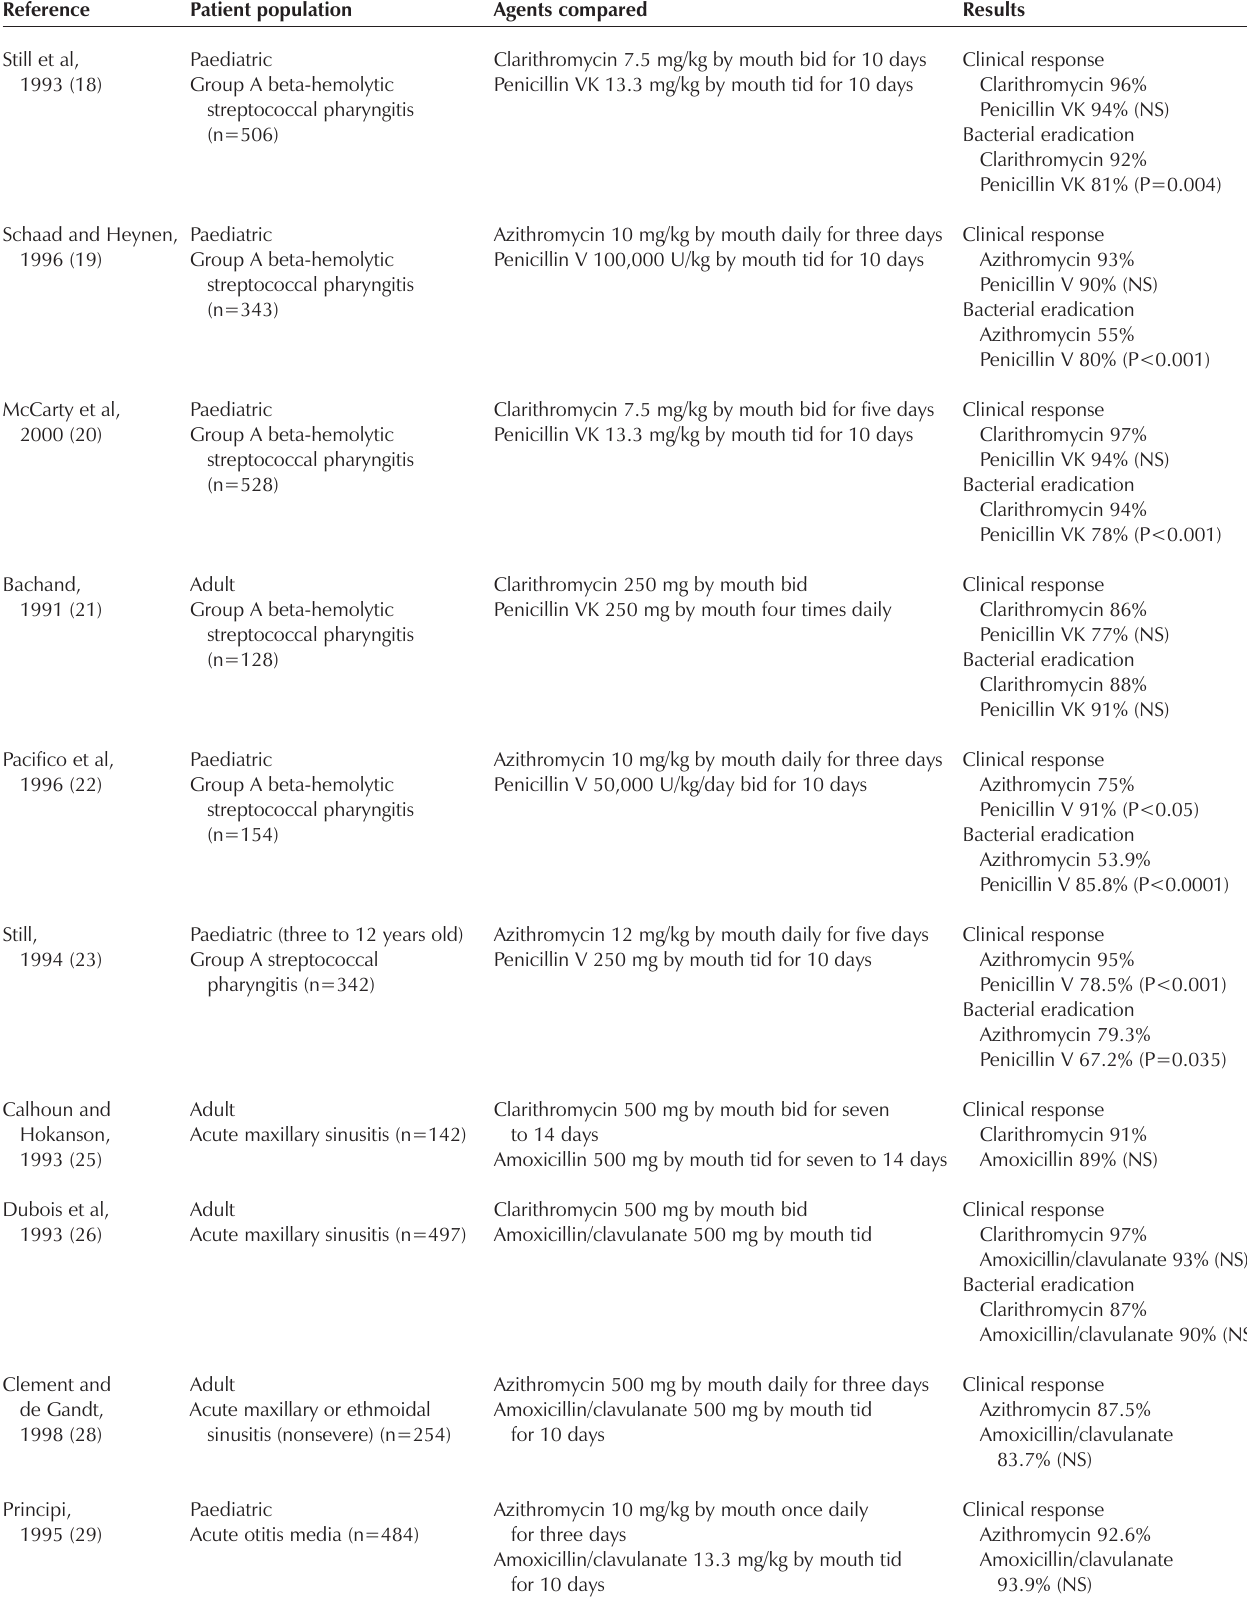
Comparative clinical trials: Respiratory tract